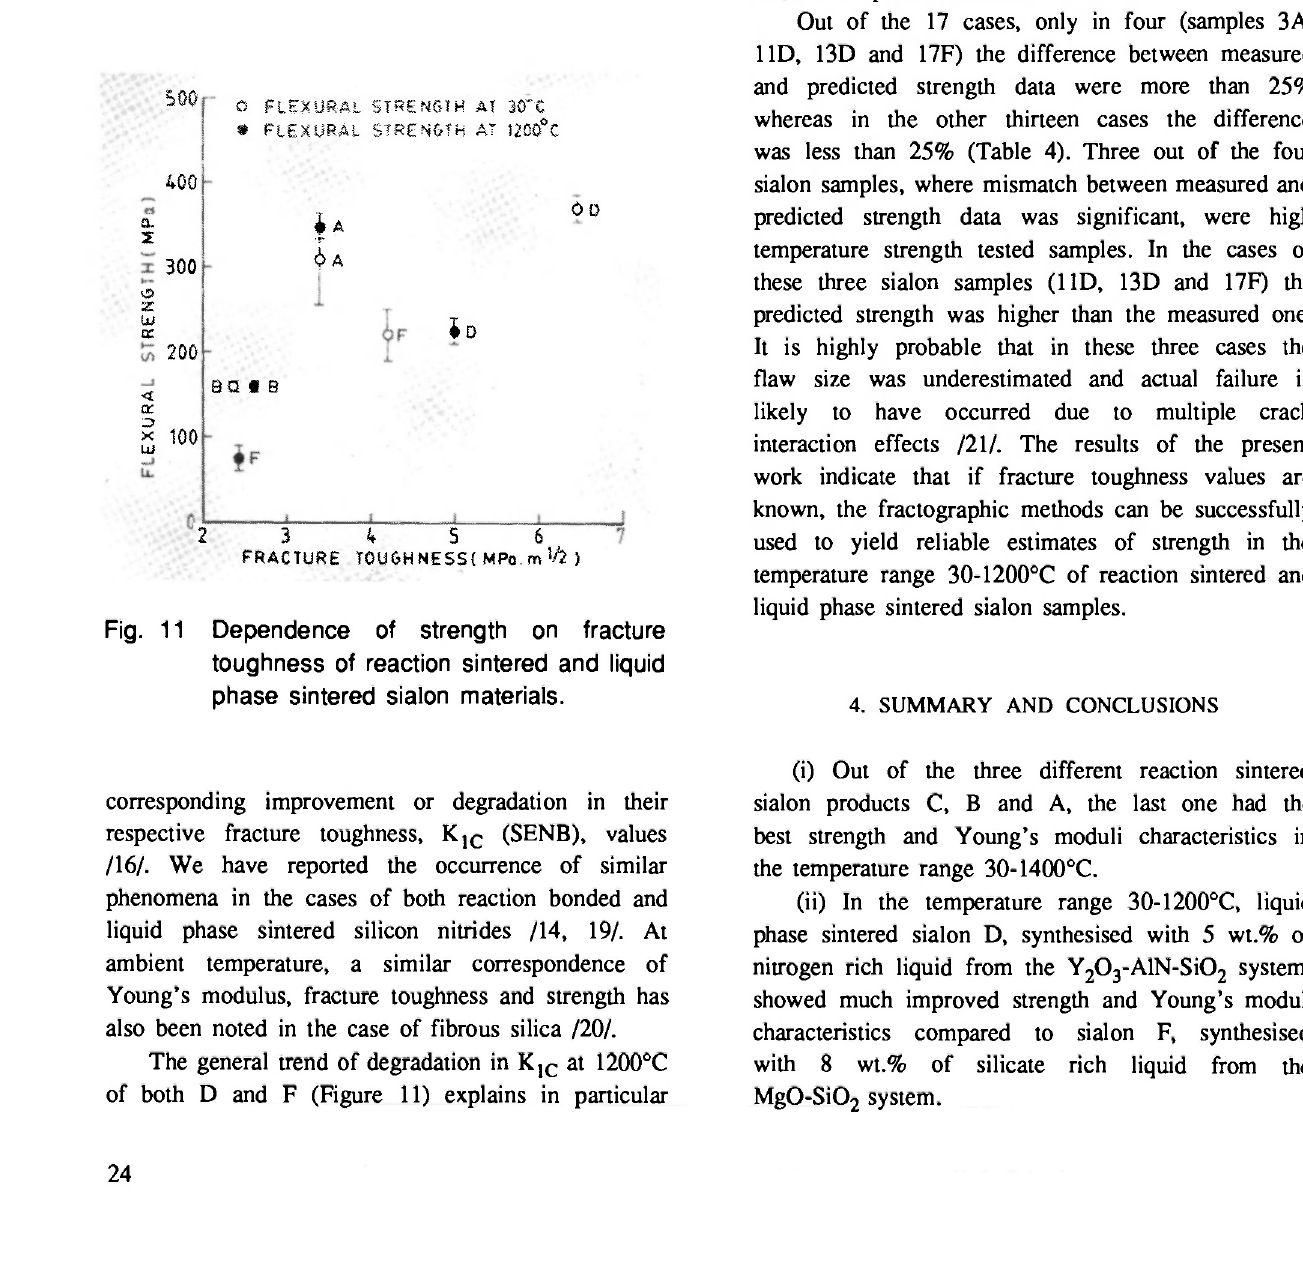
Fig. 10 Interdependence of strength and Young's moduli for reaction sintered and liquid phase sintered sialon materials.